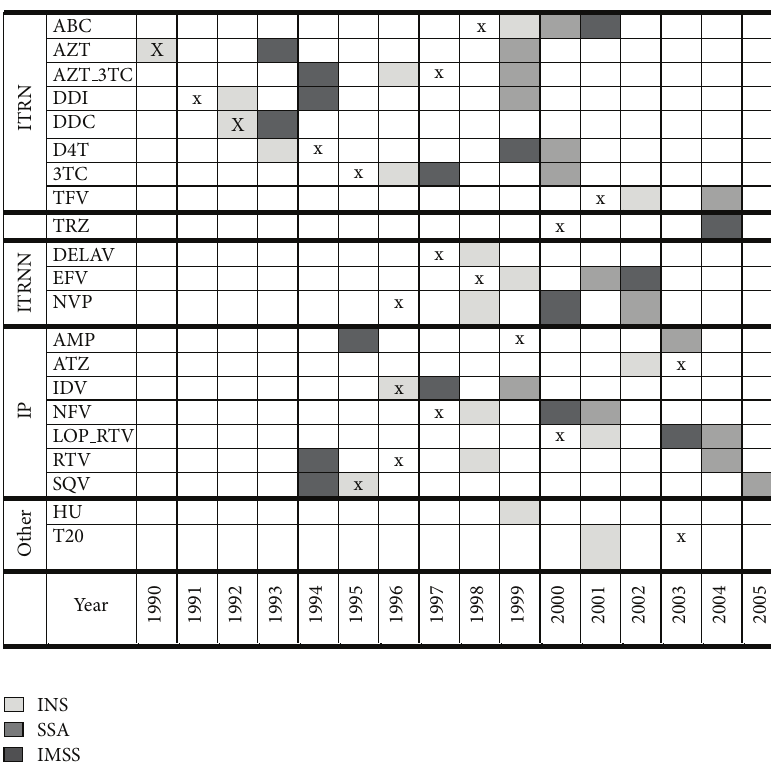
Figure 2: Type of drugs used by subsystem and year of introduction. Note . Every drug was used beginning at the year marked in the figure during the period of study, with the following exceptions in the INS: DELAV was used between 1998 and 1999, HU was used between 1999 and 2000, and DDC was used between 1992 and 1998. The “x” indicates the year the FDA approved the drug, except for AZT which was approved in 1987